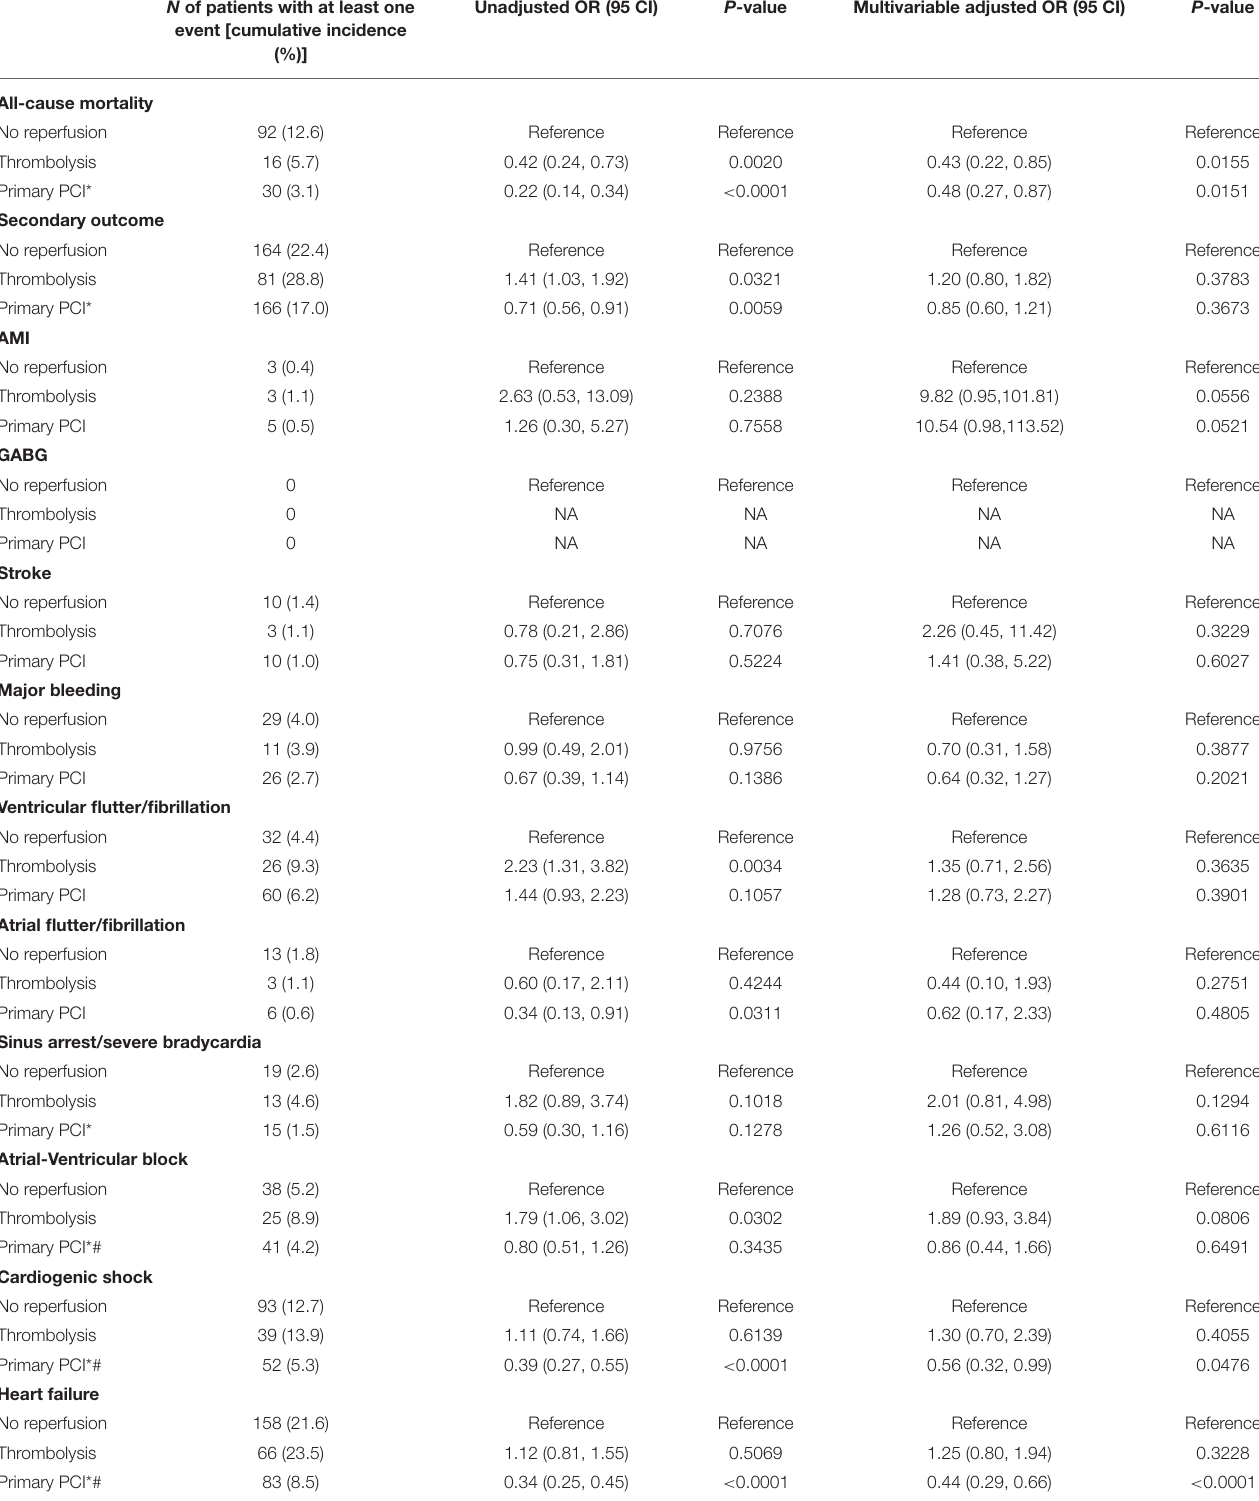
TABLE 2 | Comparison of in-hospital outcomes according to treatment strategies in patients with right ventricular infarction. N of patients with at least one Unadjusted OR (95 CI) P -value Multivariable adjusted OR (95 CI) P event [cumulative incidence (%)]